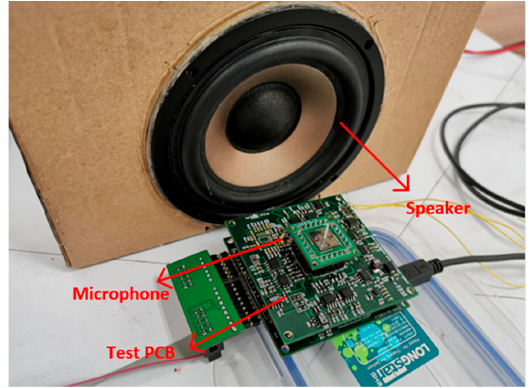
Figure 13. The outputs of the hair flow sensor under steady air flow from 1 m/s to 6 m/s. ( A ) Sensitivity on the x-axis. ( B ) Sensitivity on the y-axis.